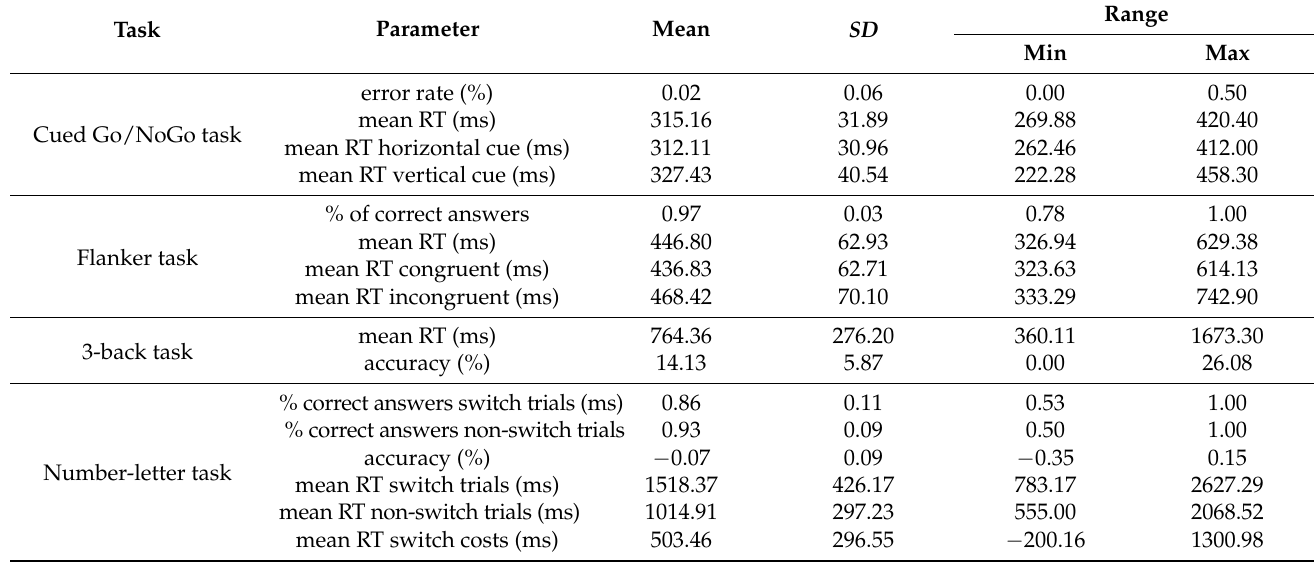
Table 1. Descriptive results of performance-based EF tasks.